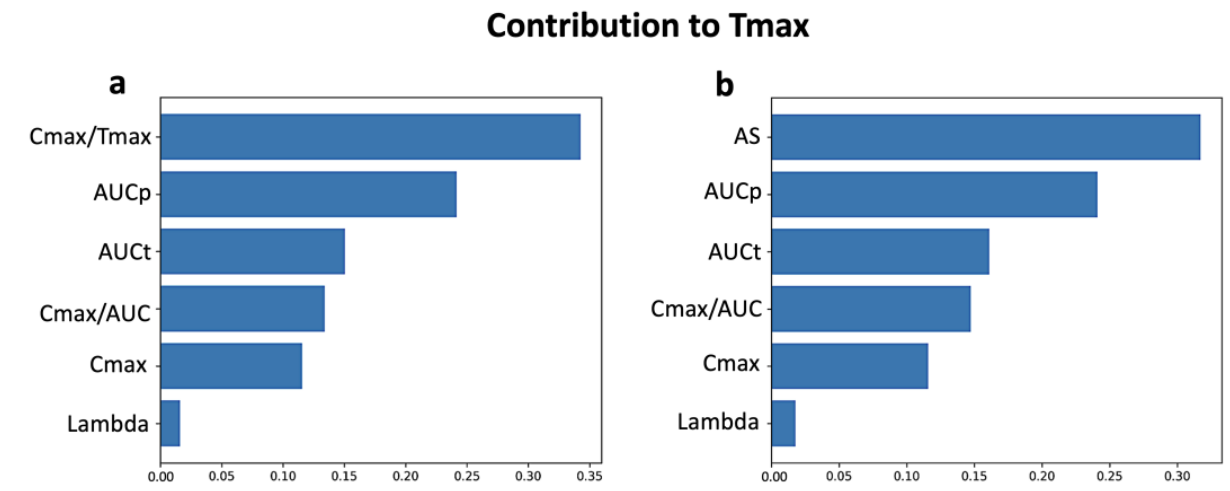
Figure 4. Variable importance scores for the random forest models using Tmax as the response variable. The Cmax/Tmax ratio is used in ( a ), while the average slope (AS) is utilized in ( b ). All pharmacokinetic parameters were calculated from the actual data. The quartiles of the Tmax distribution were used to define its four categories.